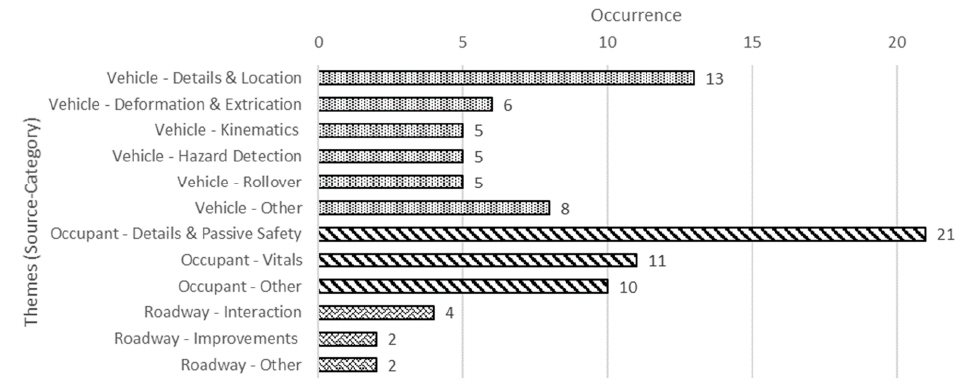
Figure 3. Twelve themes that the interviewed EMTs mentioned when addressing what information they wanted to have to improve the effectiveness and efficiency of vehicle collisions responses.